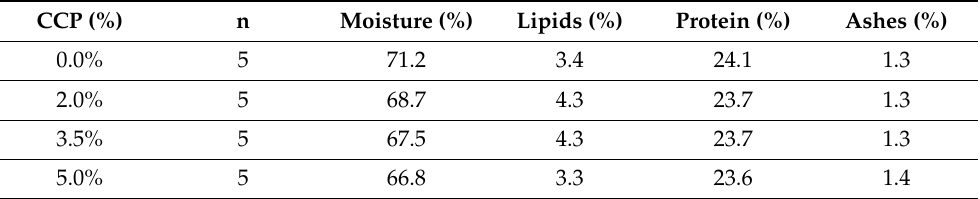
Table 1. Proximate composition (% wb) of ground beef control and treatments with the addition of camu-camu powder as determined on the initial day of the